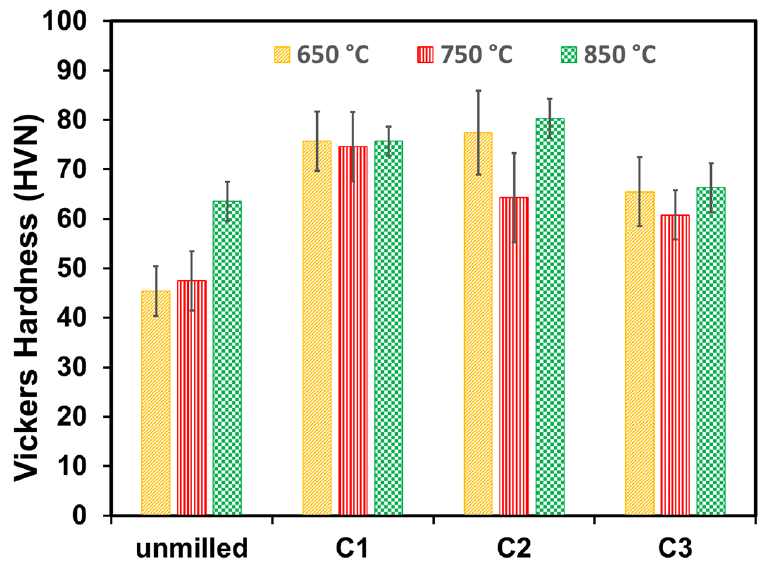
Figure 10. The hardness of sintered samples.